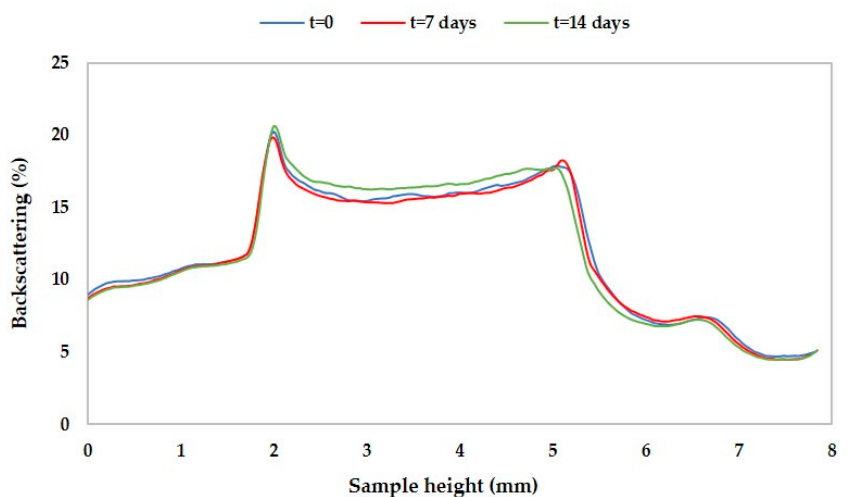
Figure 5. Exemplary backscattering (%) profiles of the obtained functionalized bilosomes as a function of sample height (mm) analyzed over 14 days of storage. Blue line represents measurement at 0 day (freshly prepared bilosomes); red line was recorded after 7 days of their storage, while green line indicates data obtained after 14 days of storage. See description of the system in Table 1.